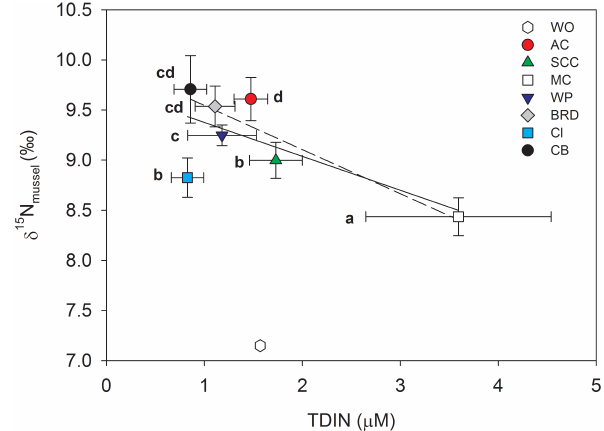
Figure 6. Relationship between mean mussel δ 15 N (‰) and to- tal dissolved inorganic nitrogen (TDIN) (µM). Error bars repre- sent standard deviation for mussels ( N = 6 for all sites except for WP where N = 5) and standard error of for TDIN ( n = 17). The solid line represents the relationship calculated for all sites ( r 2 = 0 . 486, y =− 0.338x + 9.71), the dashed line when site Cl is omitted ( r 2 = 0 . 838, y =− 0.440x + 9.98). Letters indicate differ- ences in δ 15 N mussels (ANOVA with Games–Howell post hoc test), with sites sharing the same letter being not significantly different. WO was not included in the regressions.